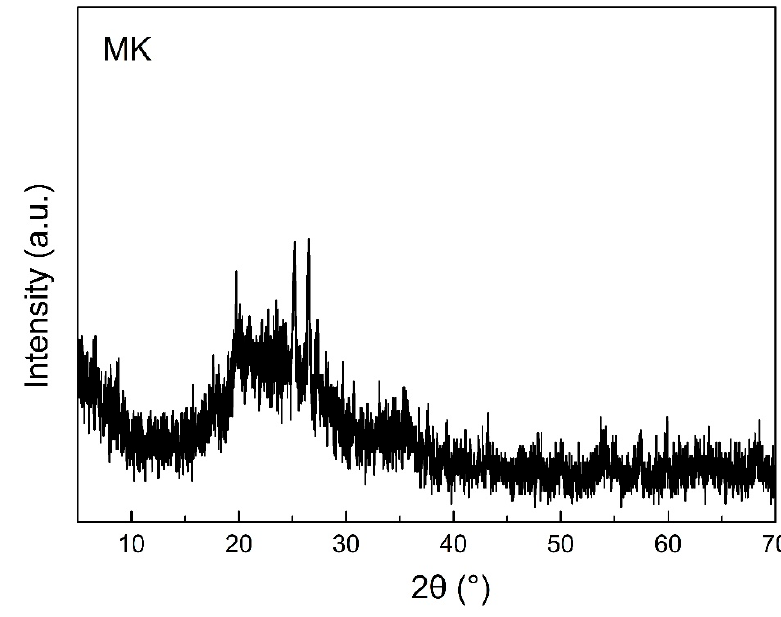
Figure 1. XRD pattern of MK.